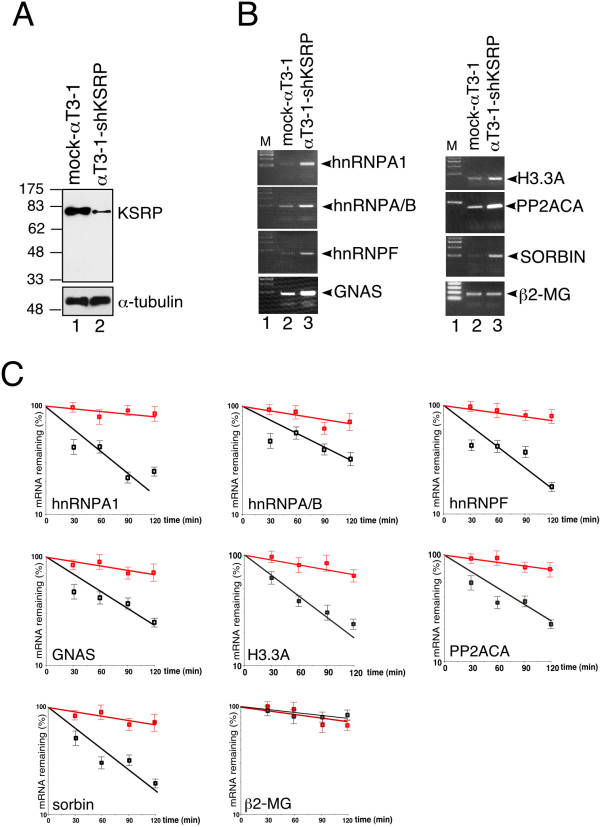
KSRP is required for rapid degradation of a set of unstabletranscripts. (A) Immunoblot analysis of total extracts from either mock-αT3-1 (empty pSUPER-Puro vector-transfected) or αT3-1-shKSRP (pSUPER-Puro-shKSRP-transfected) cells using affinity-purified anti-KSRP and anti-α-tubulin antibodies. (B) Expression of a set of KSRP-interacting mRNAs and β2-MG (as a control), monitored by RT-PCR, in either mock-αT3-1, or αT3-1-shKSRP cells. (C) Semi quantitative RT-PCR analysis of both labile KSRP-associated mRNAs and β2-MG mRNA in either mock-αT3-1 (black lines), or αT3-1-shKSRP cells (red lines). Total RNA was isolated at the indicated times after addition of Actinomycin D. The amount of each transcript was quantitated by densitometry and plotted using a linear regression program. The values shown are averages (± SEM) of three independent experiments performed in duplicates. A quantitation of the transcripts' t(1/2) is presented in Additional file 6.